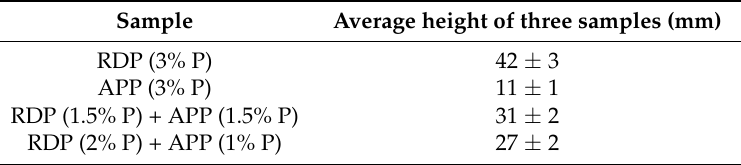
Table 5. Average heights of the charred residues.